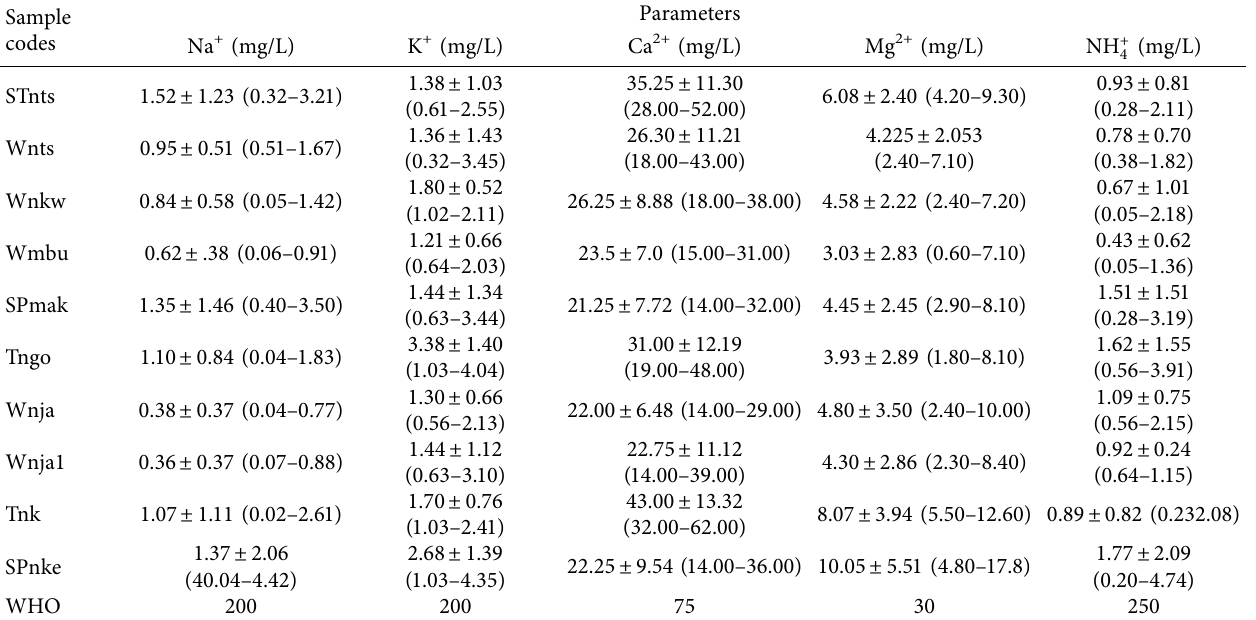
Table 3: Results of analysed cations in the samples from ten water sources in Bangolan within the study period.